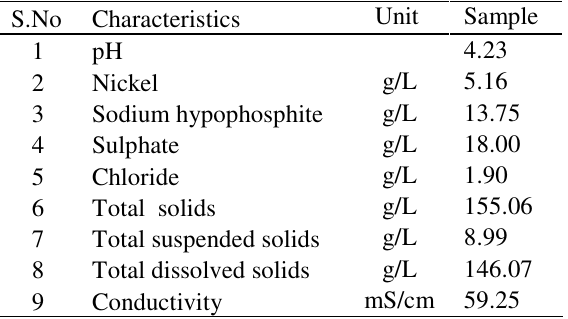
Table 1. Characteristics of spent electroless nickel bath